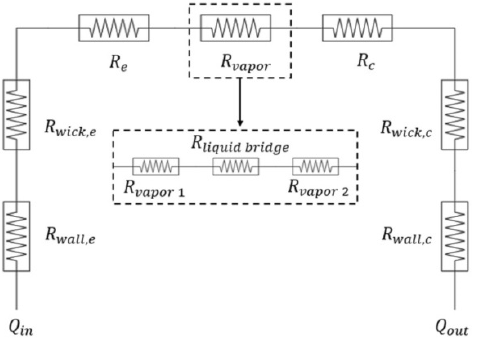
Figure 19. Thermal resistance equivalent network in the presence of liquid bridge [86].